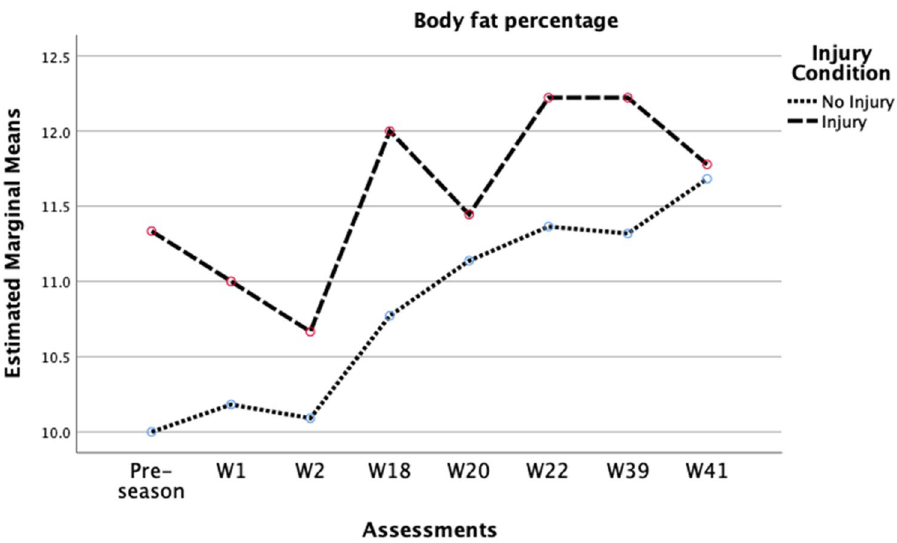
Figure 2. Variation in players’ body fat percentage across the season